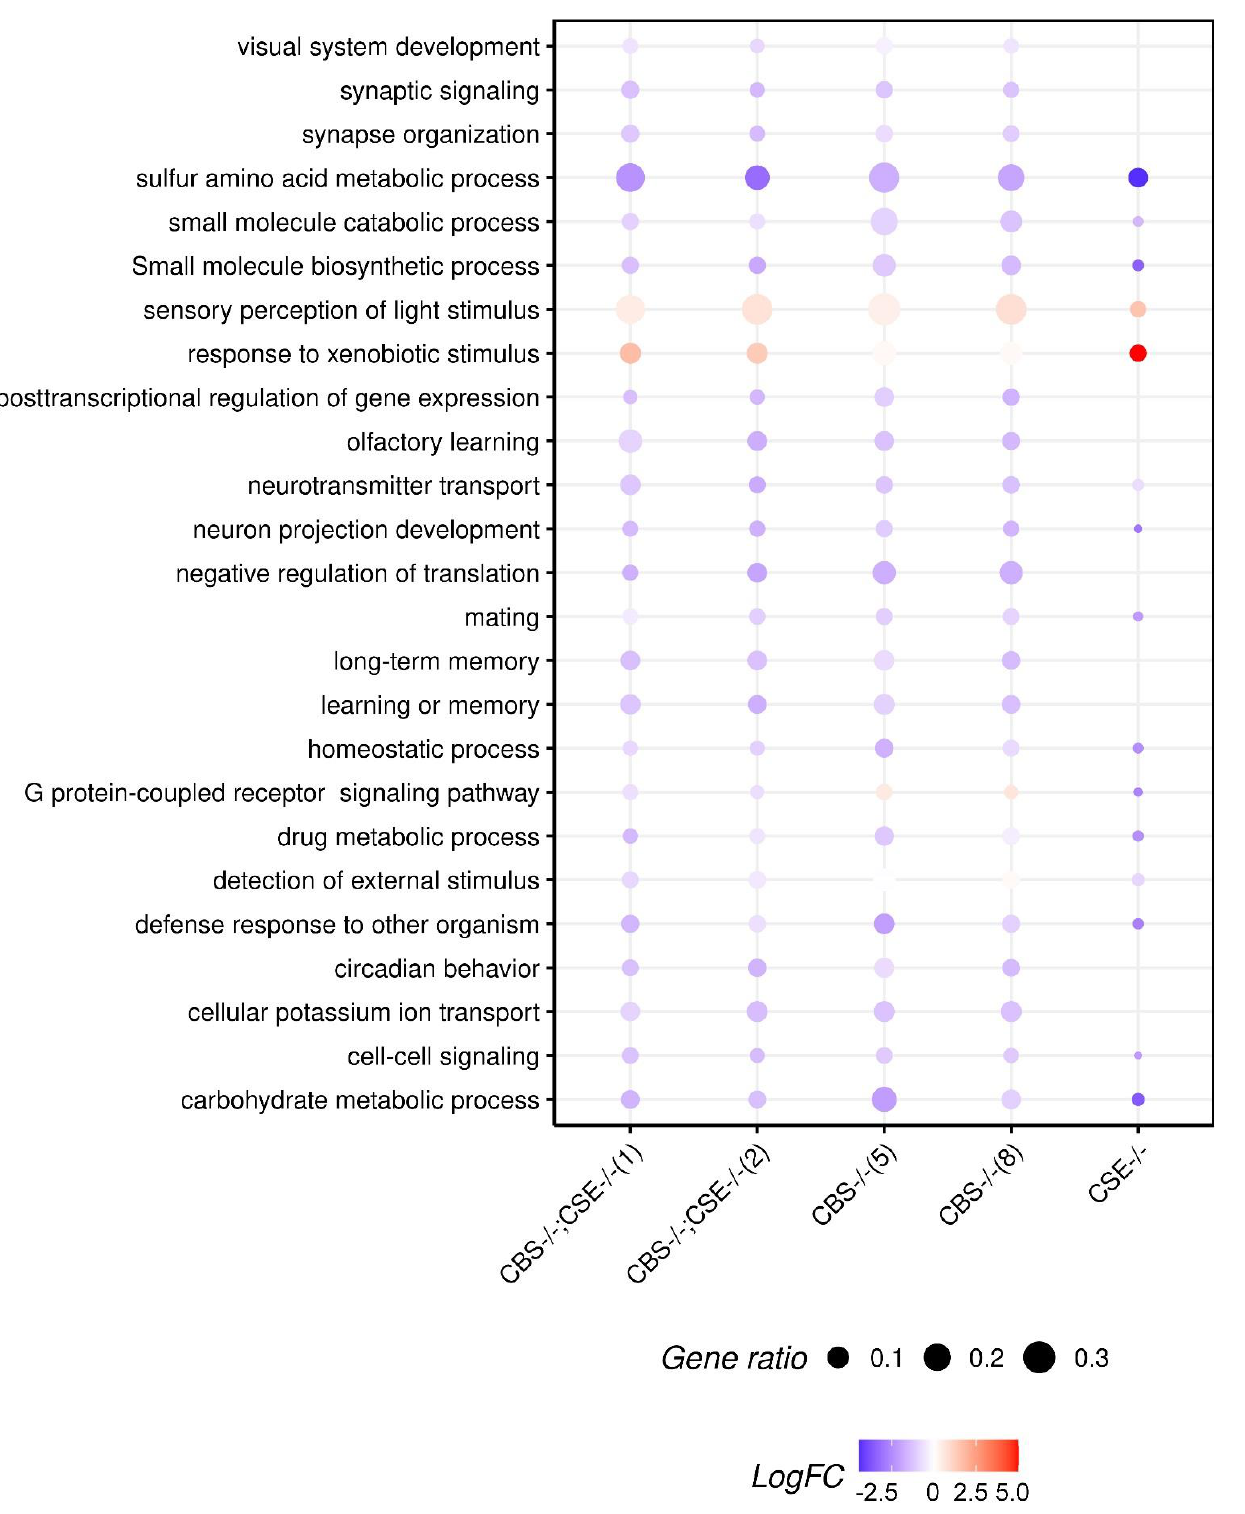
Figure 6. GSEA analysis of differentially expressed genes: X -axis represents strains, Y -axis represents, enriched Gene Ontology terms. Point colors represent averaged LogFC value between all genes (FDR < 0.05) appearing in the corresponding Gene Ontology group on the Y axis, point size—the proportion of genes with altered expression to the total number of genes in such